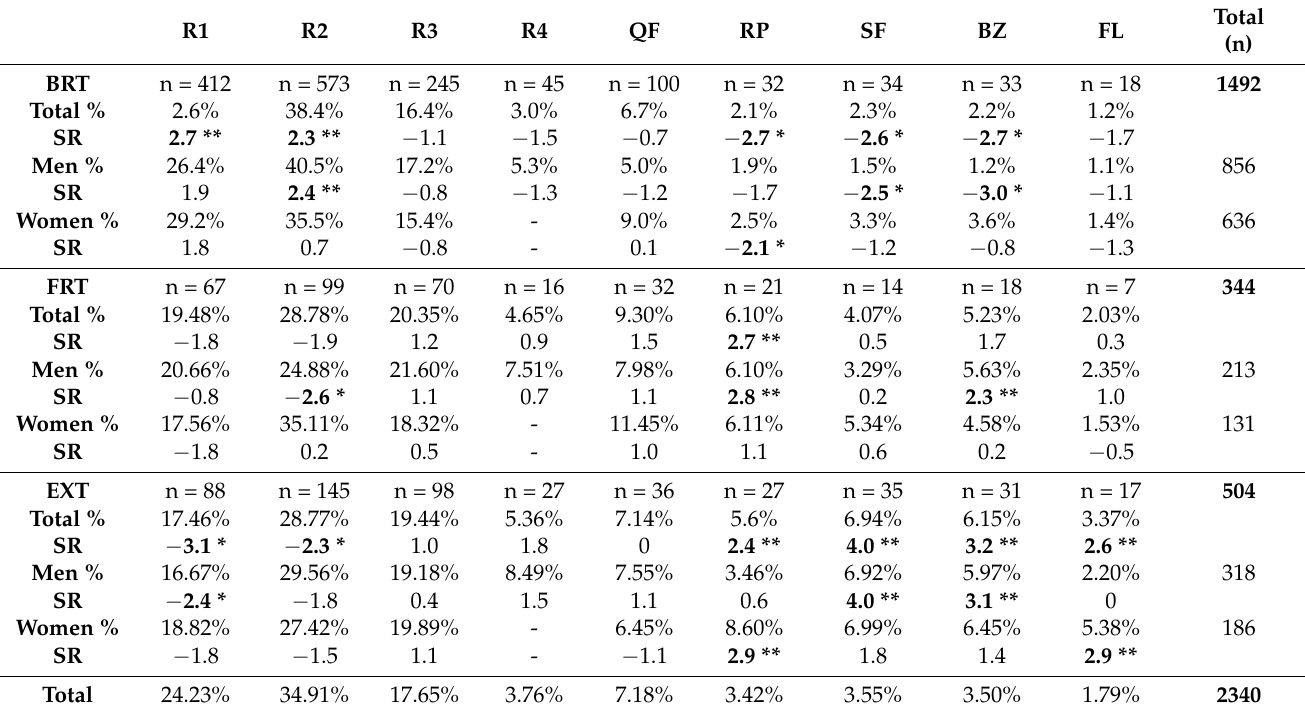
Table 7. Relation between WhCE (BRT, FRT and EXT) and round for the whole sample and for men and women (n = 2340).